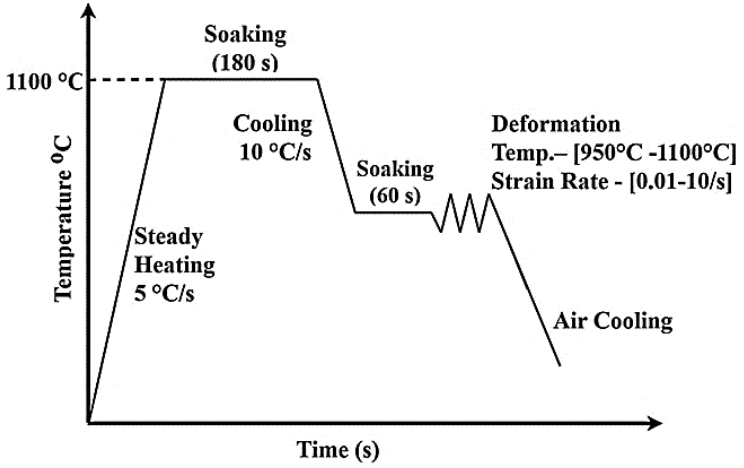
Figure 3. Thermal deformation profile.